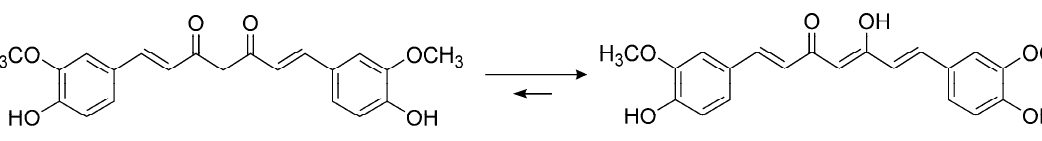
Figure 1. Chemical structure of curcumin and keto–enol tautomerism.